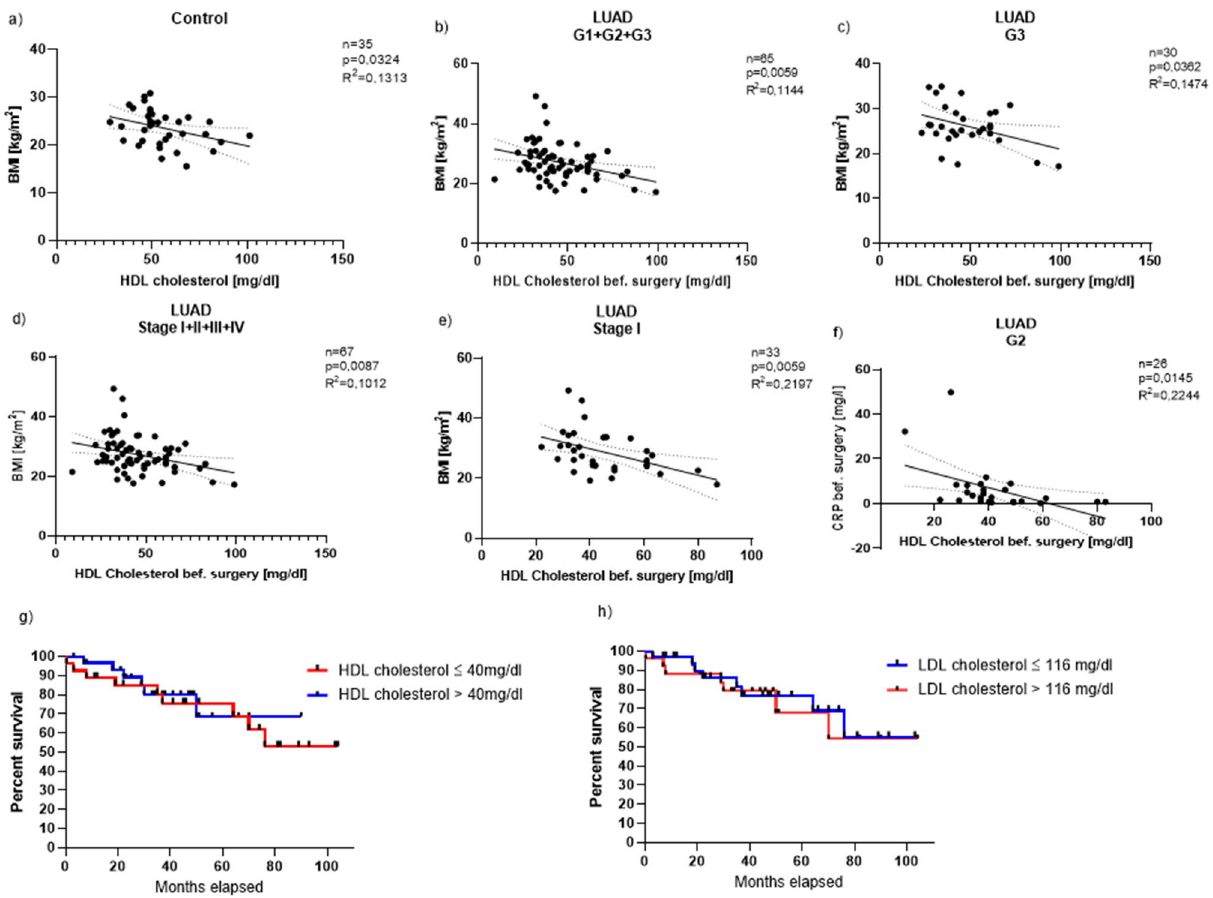
Figure 3. Pre-surgical HDL cholesterol values inversely correlate with the BMI in dependence of the grading/ the TNM classification. ( a ) Direct correlation between the HDL cholesterol values and the BMI of all control patients (n = 35, p = 0.0324, R 2 = 0.1313). ( b ) Direct correlation between the HDL cholesterol values before surgery and the BMI of all LUAD patients (G1 + G2 + G3) in dependence of the grading (n = 65, p = 0.0059, R 2 = 0.1144). ( c ) Direct correlation between the HDL cholesterol values before surgery and the BMI of all LUAD patients with G3 in dependence of the grading (n = 30, p = 0.0362, R 2 = 0.1474). ( d ) Direct correlation between the HDL cholesterol values before surgery and the BMI of all LUAD patients (Stage I + II + III + IV) in dependence of the TNM classification (n = 67, p = 0.0087, R 2 = 0.1012). ( e ) Direct correlation between the HDL cholesterol values before surgery and the BMI of all LUAD patients with Stage I in dependence of the TNM classification (n = 33, p = 0.0059, R 2 = 0.2197). ( f ) Direct correlation between the HDL cholesterol values before surgery and the CRP values before surgery of all LUAD patients with G2 in dependence of the grading (n = 26, p = 0.0145, R 2 = 0.2244). ( g ) Kaplan–Meier curve depending on HDL-cholesterol level in the serum before surgery (red line: HDL cholesterol ≤ 40 mg/dl: n = 30; blue line: HDL cholesterol > 40 mg/dl: n = 37). ( h ) Kaplan–Meier curve depending on LDL-cholesterol level in the serum before surgery (blue line: LDL cholesterol ≤ 116 mg/dl: n = 39; red line: LDL cholesterol > 116 mg/dl: n = 28) . Correlations are shown by using simple linear